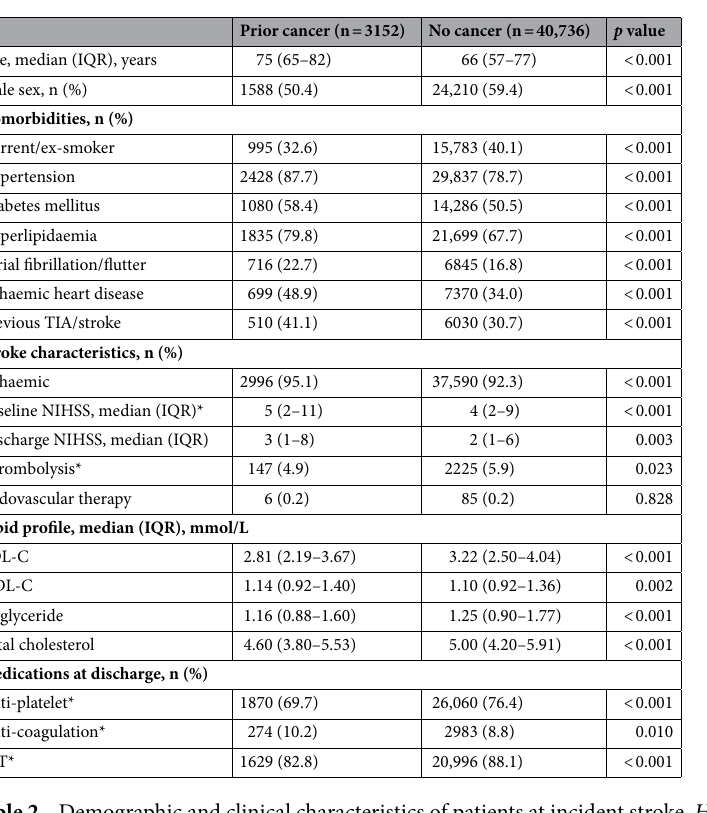
Table 2. Demographic and clinical characteristics of patients at incident stroke. HDL-C high density lipoprotein cholesterol, IQR interquartile range, LDL-C low density lipoprotein cholesterol, LLT lipid lowering therapy, NIHSS National Institutes of Health Stroke Scale, TIA transient ischaemic attack. Unknown values were excluded from the calculation of percentages. *Data on thrombolysis, anti-platelet, anti-coagulant and NIHSS scores were only available from 2008, 2009, 2010, and 2012 onwards respectively.